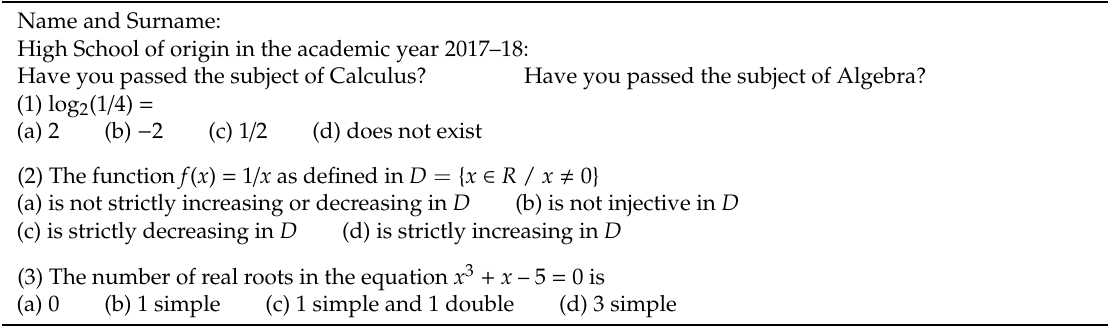
Table 1. Questions proposed in the multiple-choice level